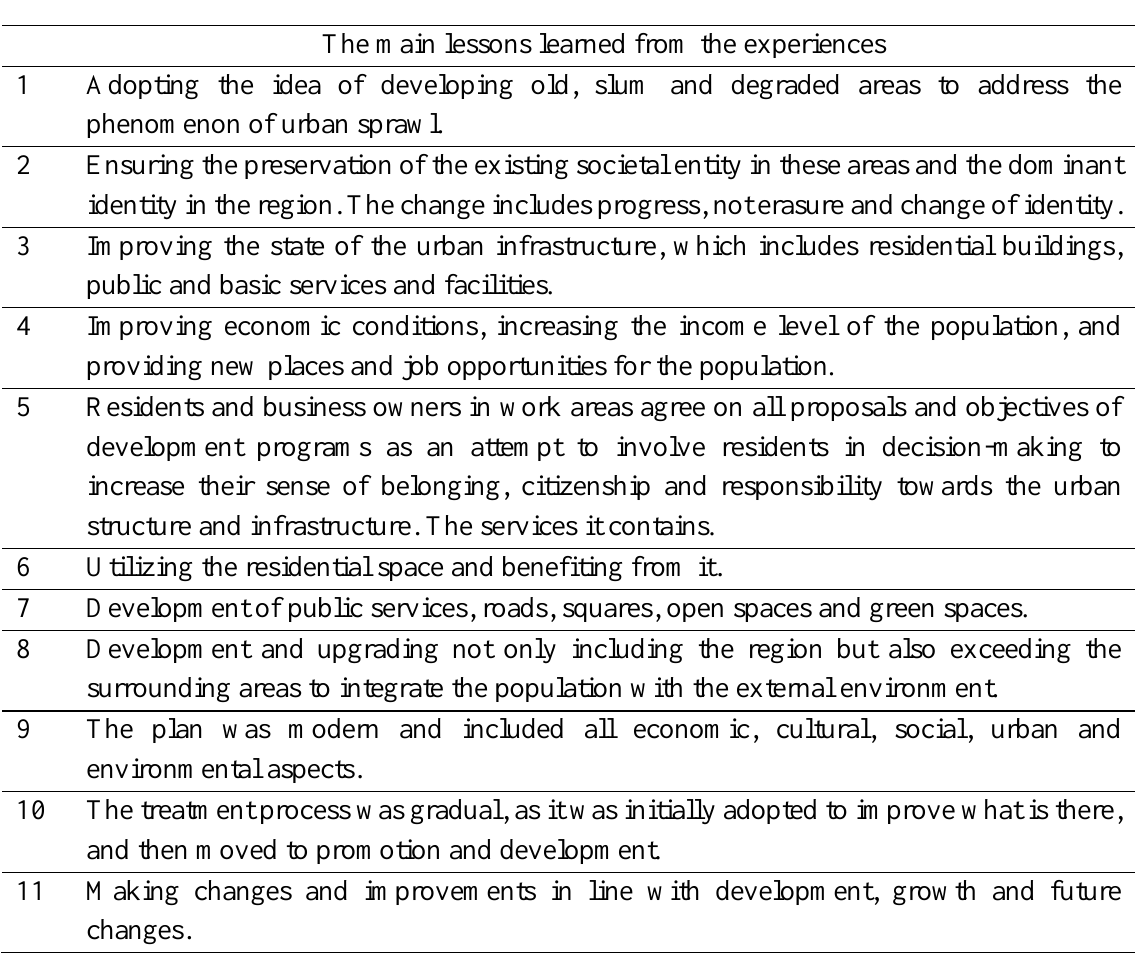
Table 3. The most prominent of what came with global experiences to confront infringement/source: reliance on the researcher's global experience of the infringement